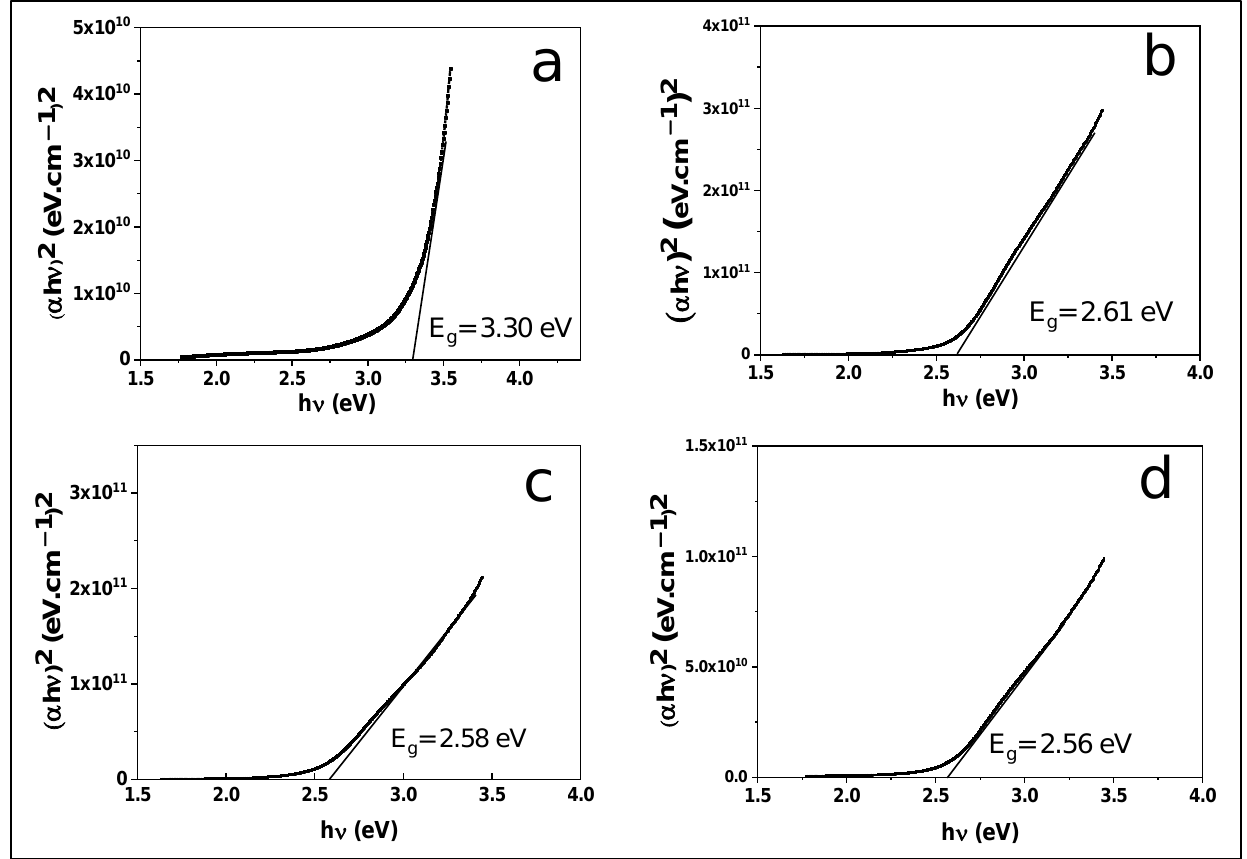
Figure 11. The energy gap of as-deposited and annealed thin films where: ( a ) as-deposited, ( b ) 20 min, ( c ) 40 min, and ( d ) 60 min.